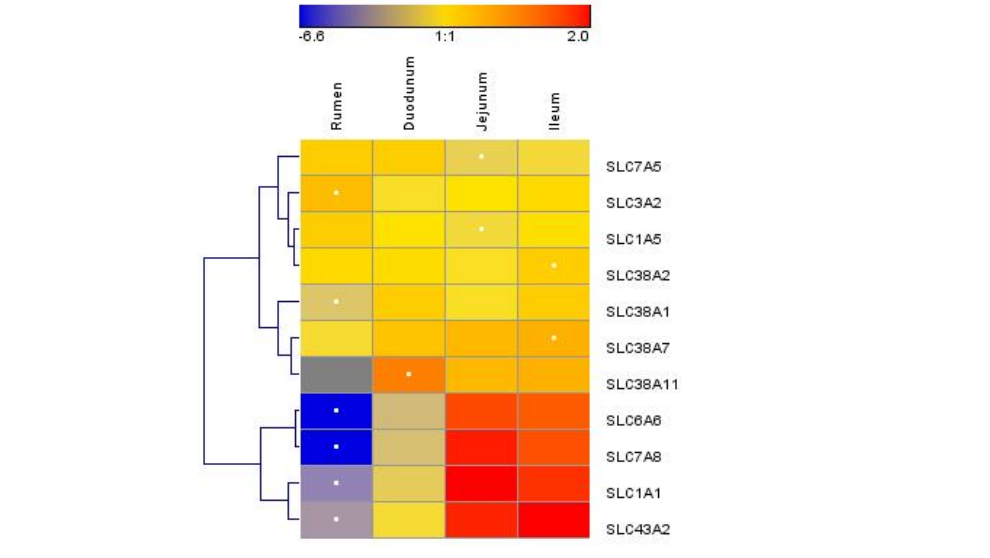
Figure 2. Hierarchical clustering of amino acid transporter abundance data in tissue harvested from the rumen, duodenum, jejunum, and ileum of lactating Holstein cows ( n = 8/group). Dendrograms allow the visualization of clusters of similarity in abundance patterns among genes between treatments (links denoted by the lines at the left side of the picture). Cutoffs for abundance level are denoted by the shades of blue, yellow, and red according to the log2-transformed least-square mean. Red intensity denotes high expression, and blue intensity indicates low expression. White dots denote the lowest or highest mRNA abundance for each gene.